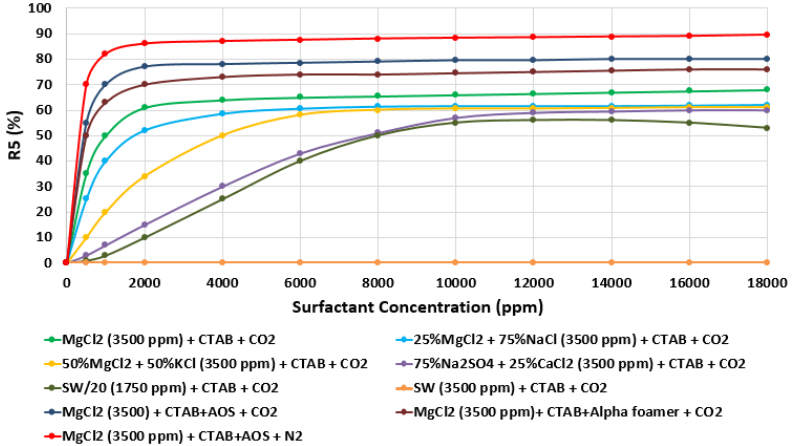
Figure 31. Variation of R5 (in percentage (%)) as a function of surfactant concentration (ppm) of different surfactant (e.g., CTAB and AOS) and various brine solutions (e.g., MgCl 2 and seawater) at 25 ◦ C.